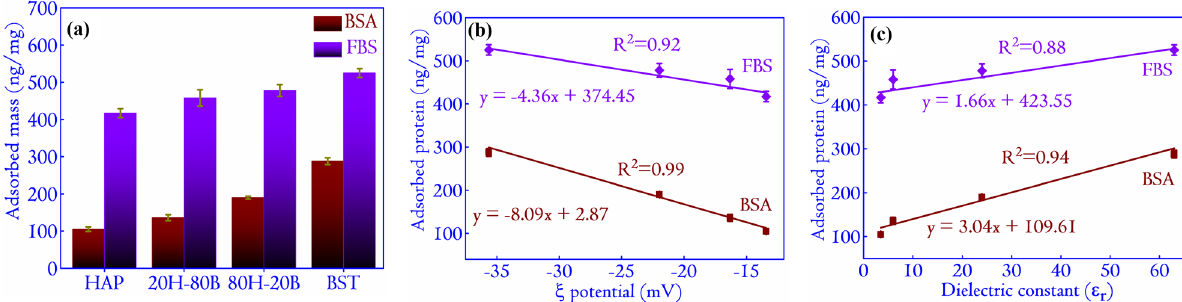
Figure 8. ( a ) The adsorbed mass of BSA and FBS on selected ceramic composites. The mathematical modeling of the behavior of the adsorbed proteins with respect to the 𝜁 potential for ( b ) BSA and FBS follows a linear relation y = mx + c , with the parameters specified appropriately in the diagram. In (c), the variation of adsorbed proteins with 𝜖 r is plotted. Similar to 𝜁 potential, the variation with 𝜖 r is also